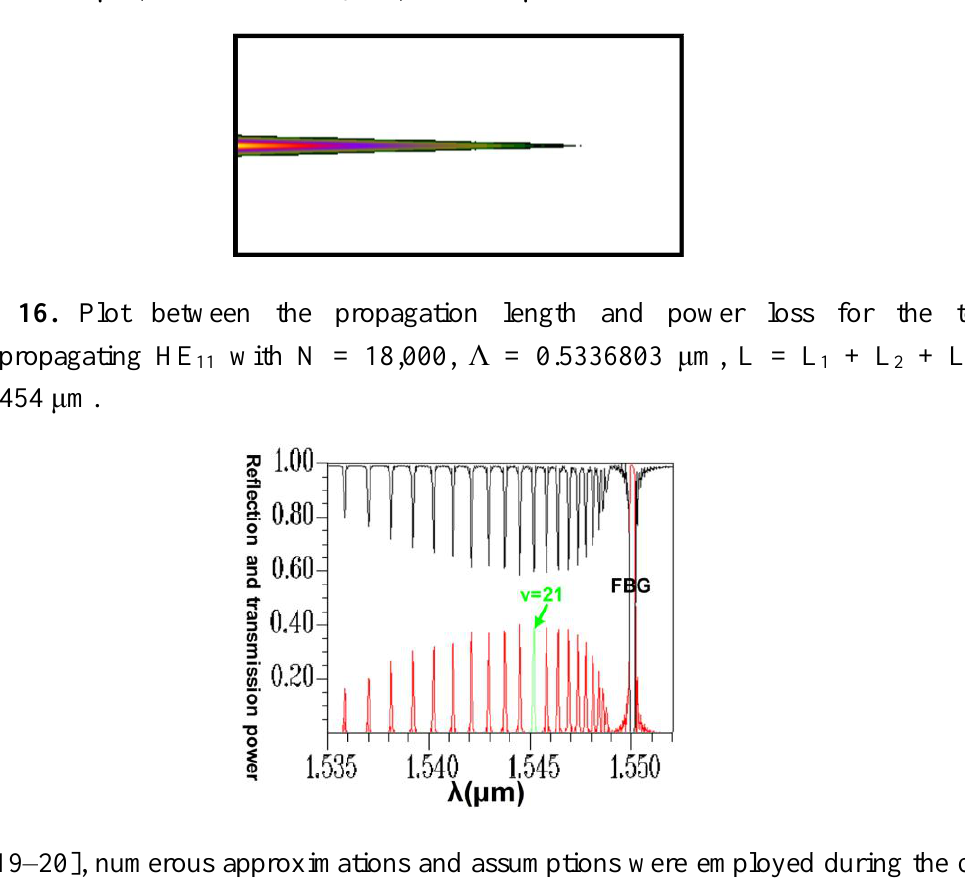
Figure 15. Plot between the orthogonal values of the 50 guided modes with N = 18,000, Λ = 0.5336803 μm, L = L